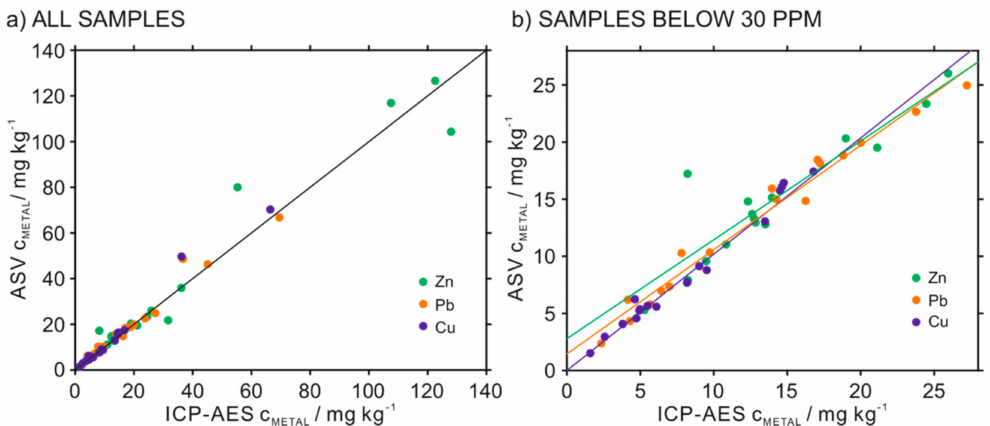
Figure 8. ( a ) Correlation plot of the concentration values in the soil samples detected by the HMDE and ICP-AES methods. Sample matrix size of 57. ( b ) Correlation plot of the concentrations values in the soil samples presented a metal content below 30 mg kg − 1 . Sample matrix size of